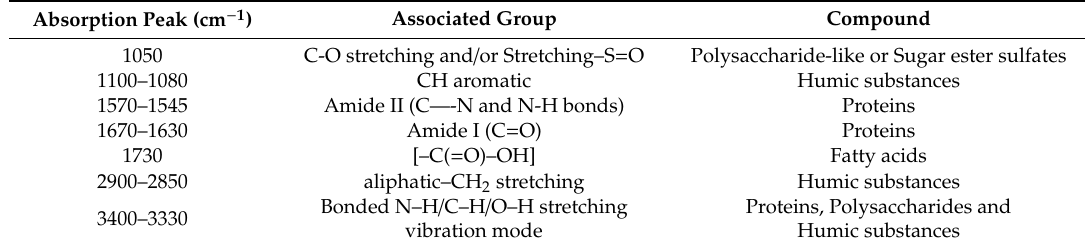
Table 8. Peaks and assignments of infrared spectra for clean and fouled